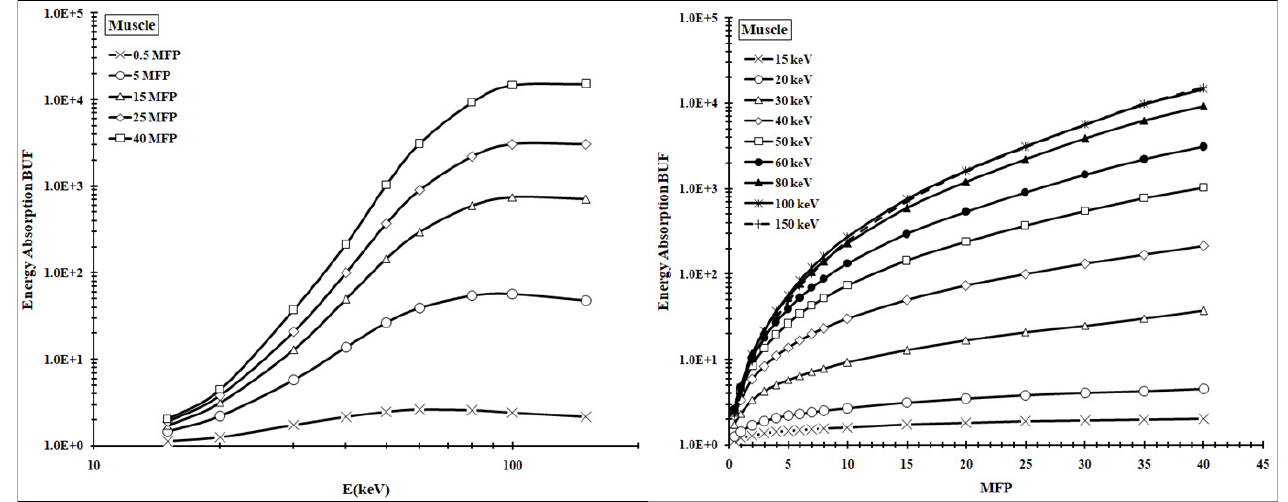
Figure 10. Energy absorption buildup factor for muscle tissue as a function of: ( left side) photon energy for fixed depths between 0.5 and 40 mfp and ( right side) depth for fixed photon energy between 15 and 150